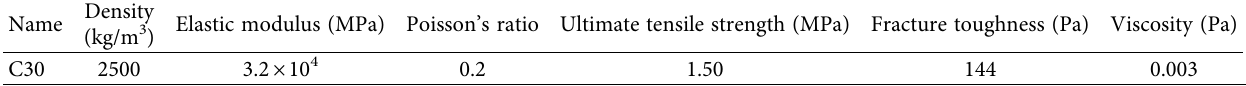
Table 1: Parameters of concrete material.